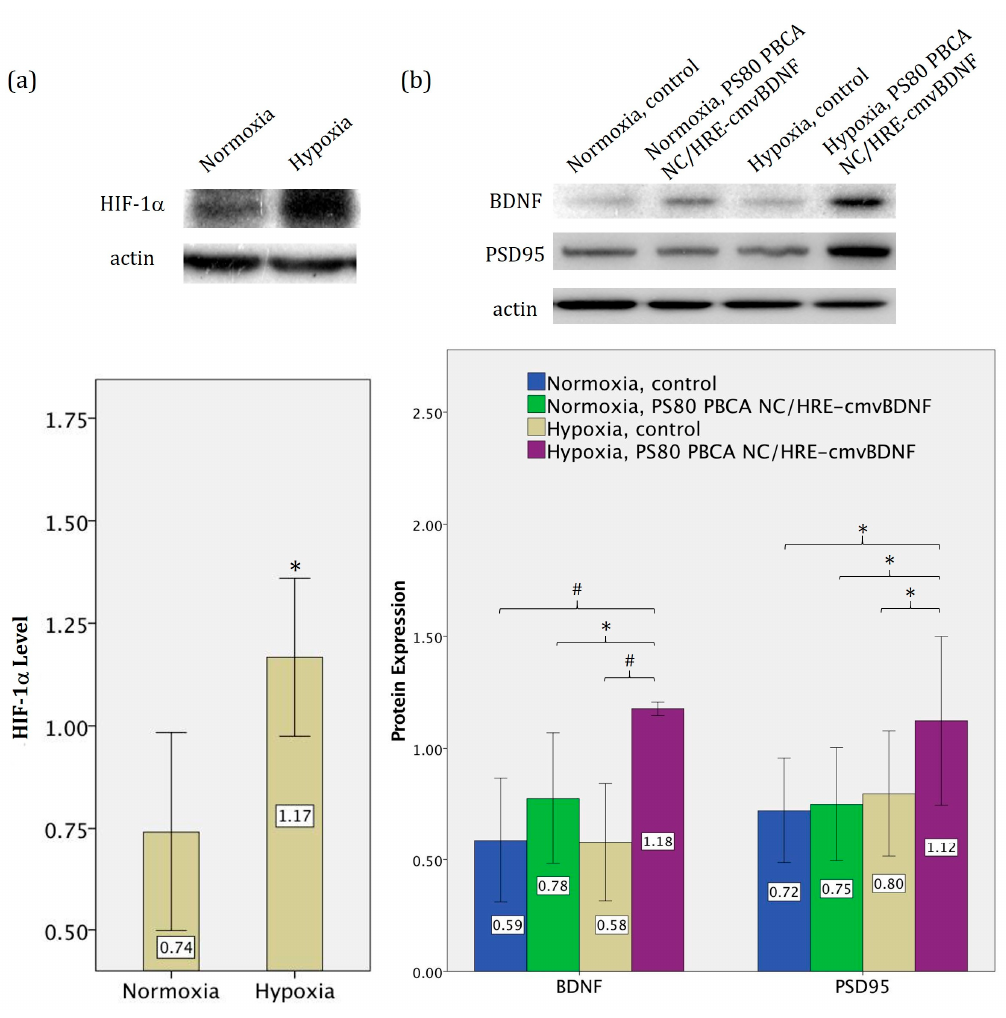
Figure 8. ( a ) The level of HIF-1 α in iPSCs exposed to 4 h of hypoxia was significantly higher than in those without hypoxia; and ( b ) BDNF expression was not significantly different in untreated controls with or without prior exposure to hypoxia, and no significant alteration was found in PS80 PBCA NC/HRE-cmvBDNF-treated cells (30 μ g/mL:2 μ g/mL; r = 15:1) without the hypoxic drive. PS80 PBCA NC/HRE-cmvBDNF-treated cells with prior hypoxia expressed up to 51% more BDNF than those without, and significantly elevated the postsynaptic density protein 95 (PSD95) level. n = 4; # p < 0.001; * p < 0.05.